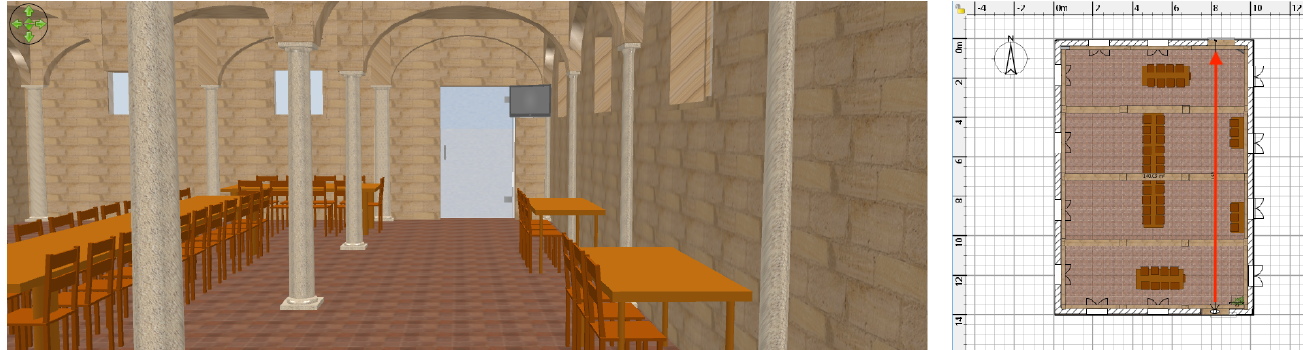
Figure 11. Three-dimensional rendering of the auditorium used for the indoor environmental perception evaluation, located inside the “Santa Elisabetta” Congress Center of the University of Parma. On the right, the walking path is